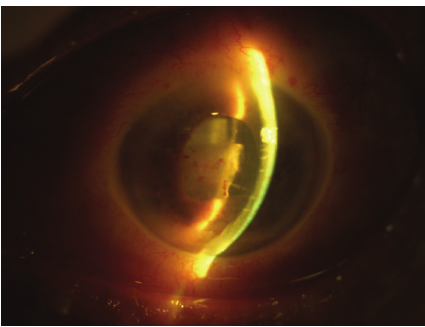
Figure 3: Dendritic lesions on the left cornea. Figure 4: Cyclitic membrane and hemorrhage in the left anterior